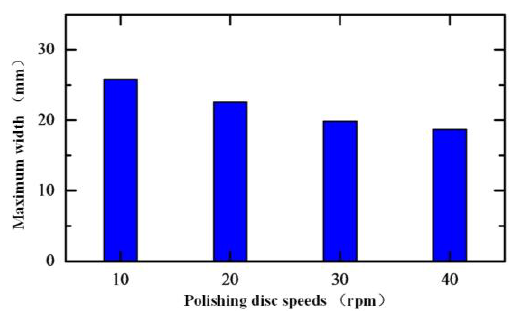
Figure 22. Scratch damage maximum width with different polishing disc speeds.